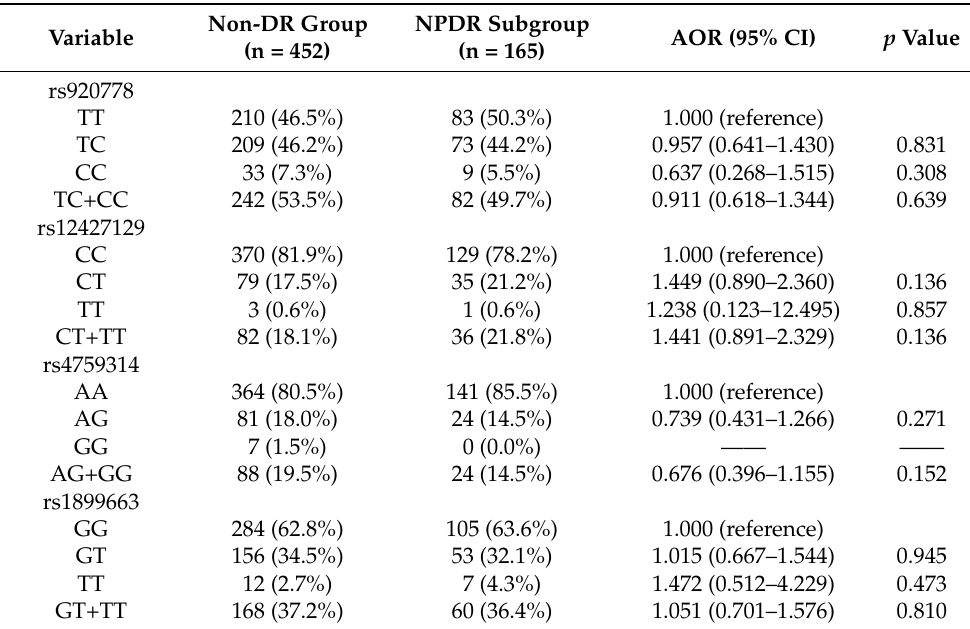
Table 3. Odds ratio and 95% confidence interval of non-proliferative diabetic retinopathy associated with HOTAIR genotypic frequencies.